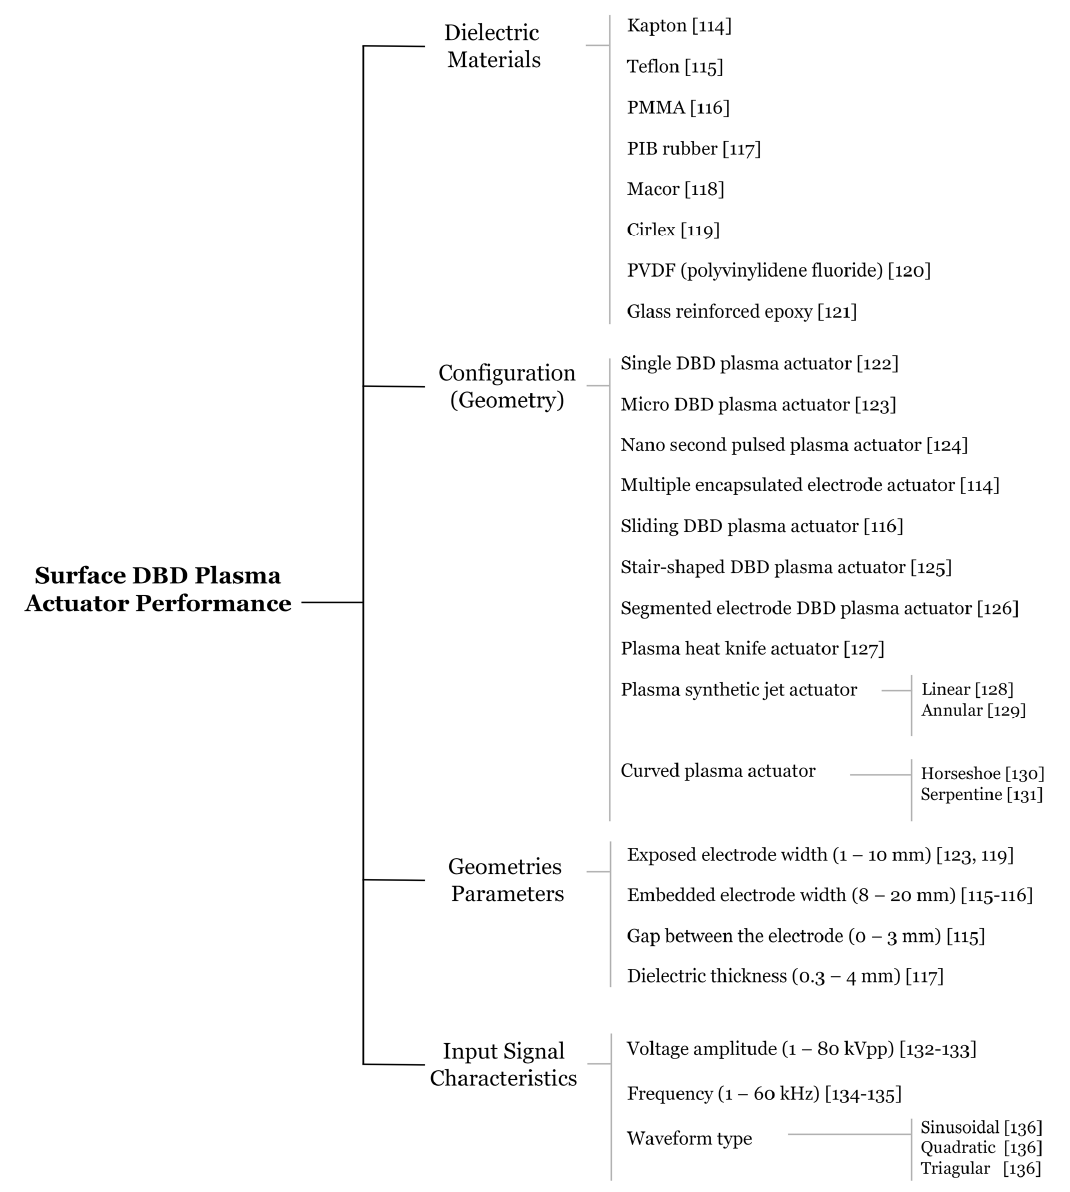
Figure 5. Surface DBD plasma actuator impact performance parameters [114–136].